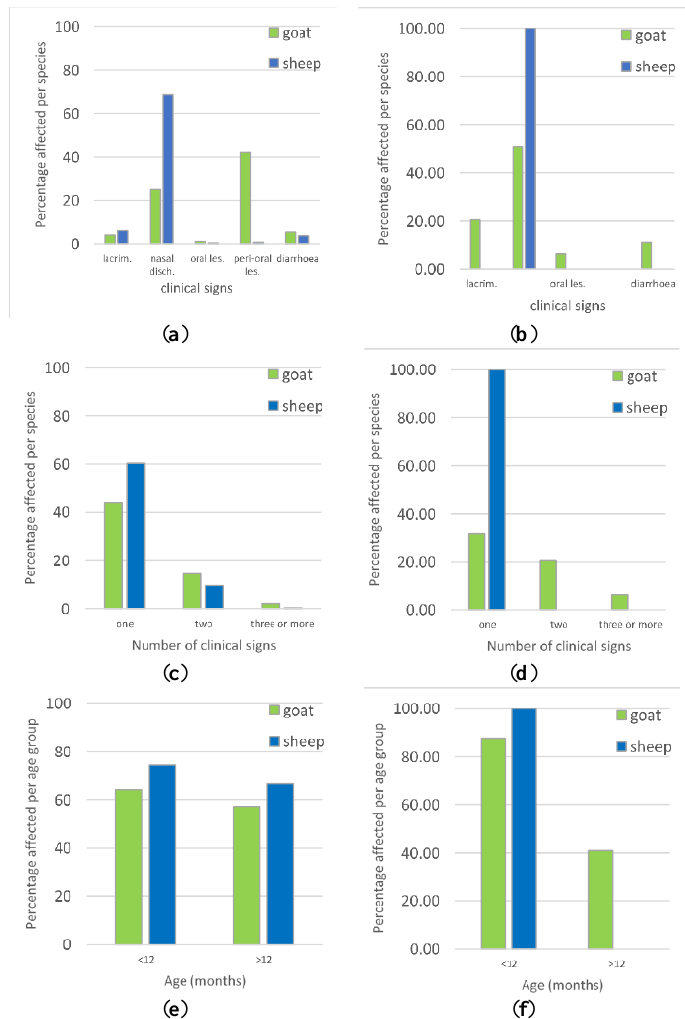
Figure 4. Prevalence of clinical signs in Flocks 1 and 3. ( a ) Prevalence of type of clinical sign in each species in Flock 1 and ( b ) Flock 3; lacrim. = lacrimation, nasal disch. = nasal discharge, oral les. = oral lesions, and peri-oral les. = peri-oral lesions. ( c ) Number of clinical signs per animal by species in Flock 1 and ( d ) Flock 3. ( e ) Prevalence of clinical disease in each age group by species in Flock 1 and ( f ) Flock 3.